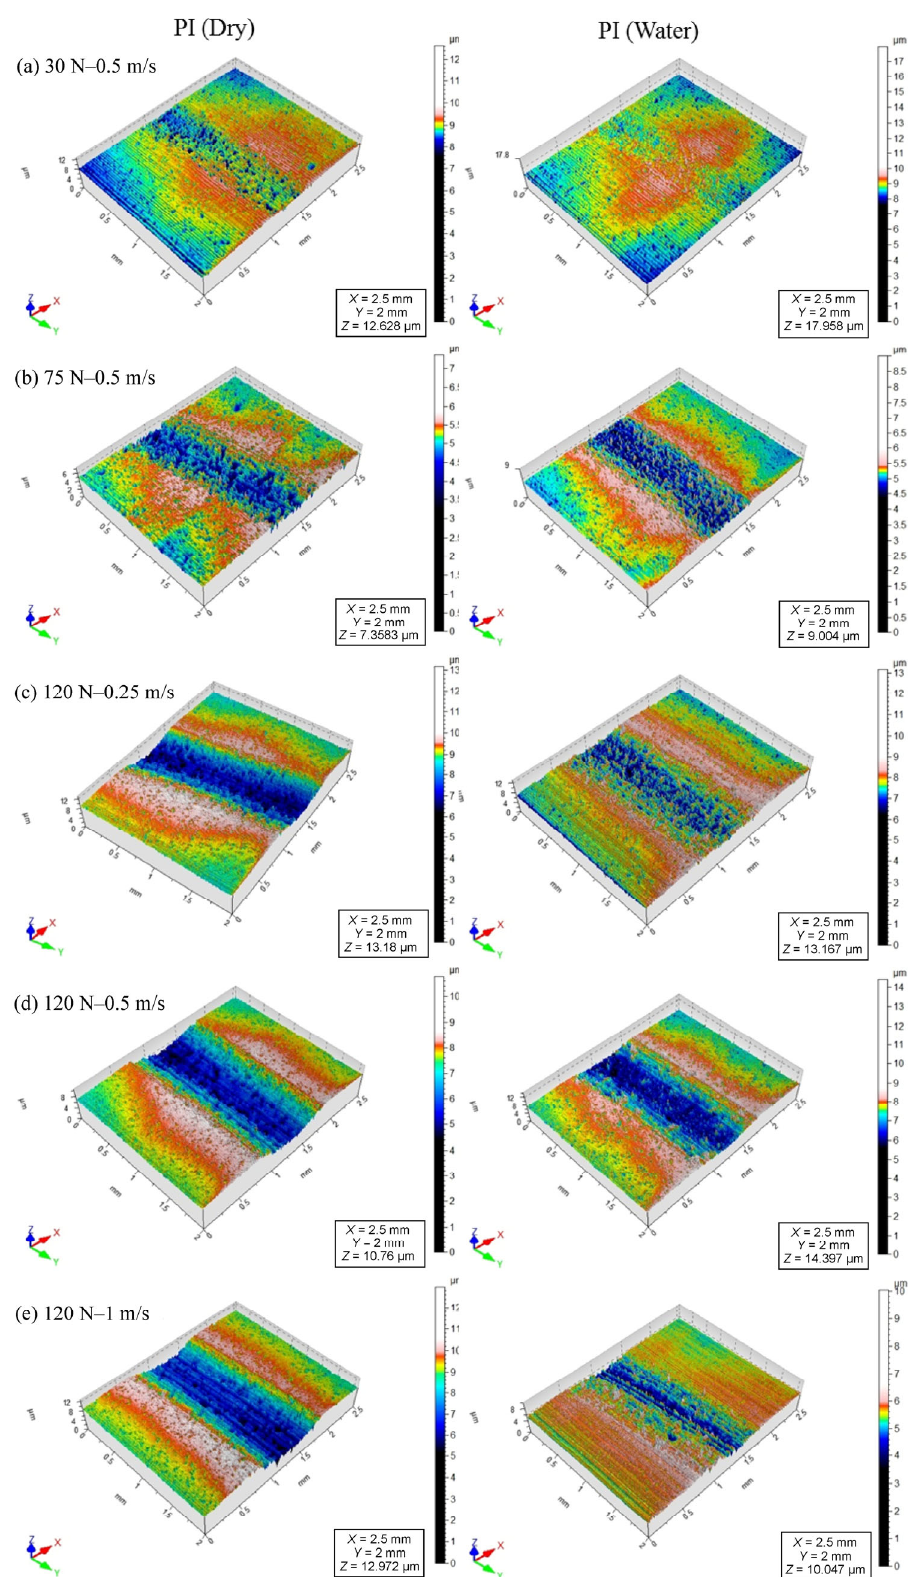
Fig. 11 3-D surface topography of PI materials after tests under different